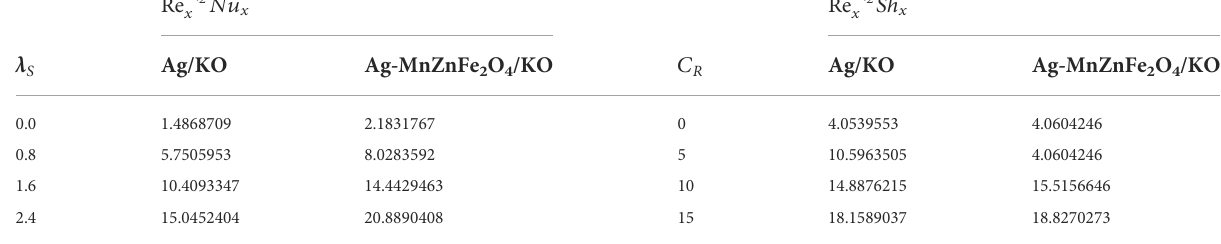
TABLE 5 Impact of activation energy and chemical reaction on Re − 1 / 2 x Sh x